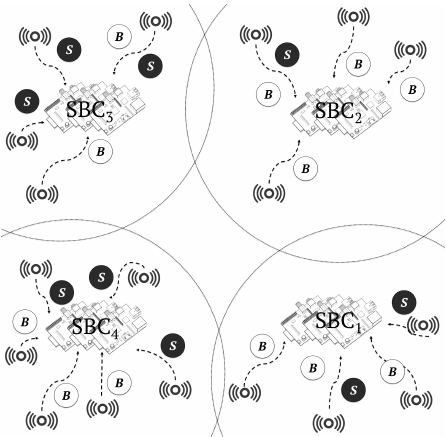
Figure 11. Cloudlet-only environment. This theoretical scenario is created only for comparison to cloud-computing environments. In this figure, a set of uniformly distributed sensors generate a workload composed of batch jobs B and service jobs S , which are deployed to four nearby cloudlets composed of 500 SBCs each, with low latency.